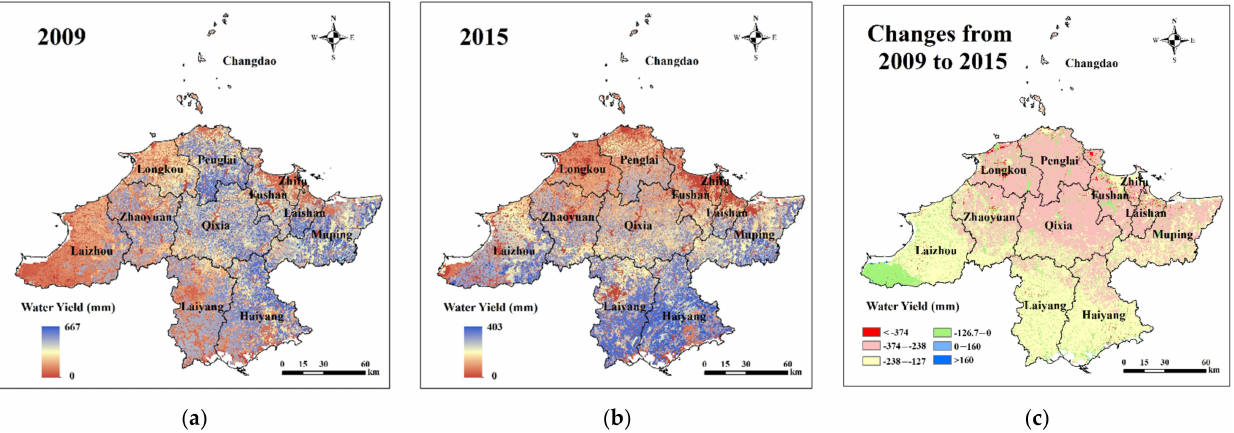
Figure 3. ( a ) Spatial distribution of water yield in Yantai in 2009; ( b ) spatial distribution of water yield in Yantai in 2015; ( c ) changes of water yield in Yantai from 2009 to